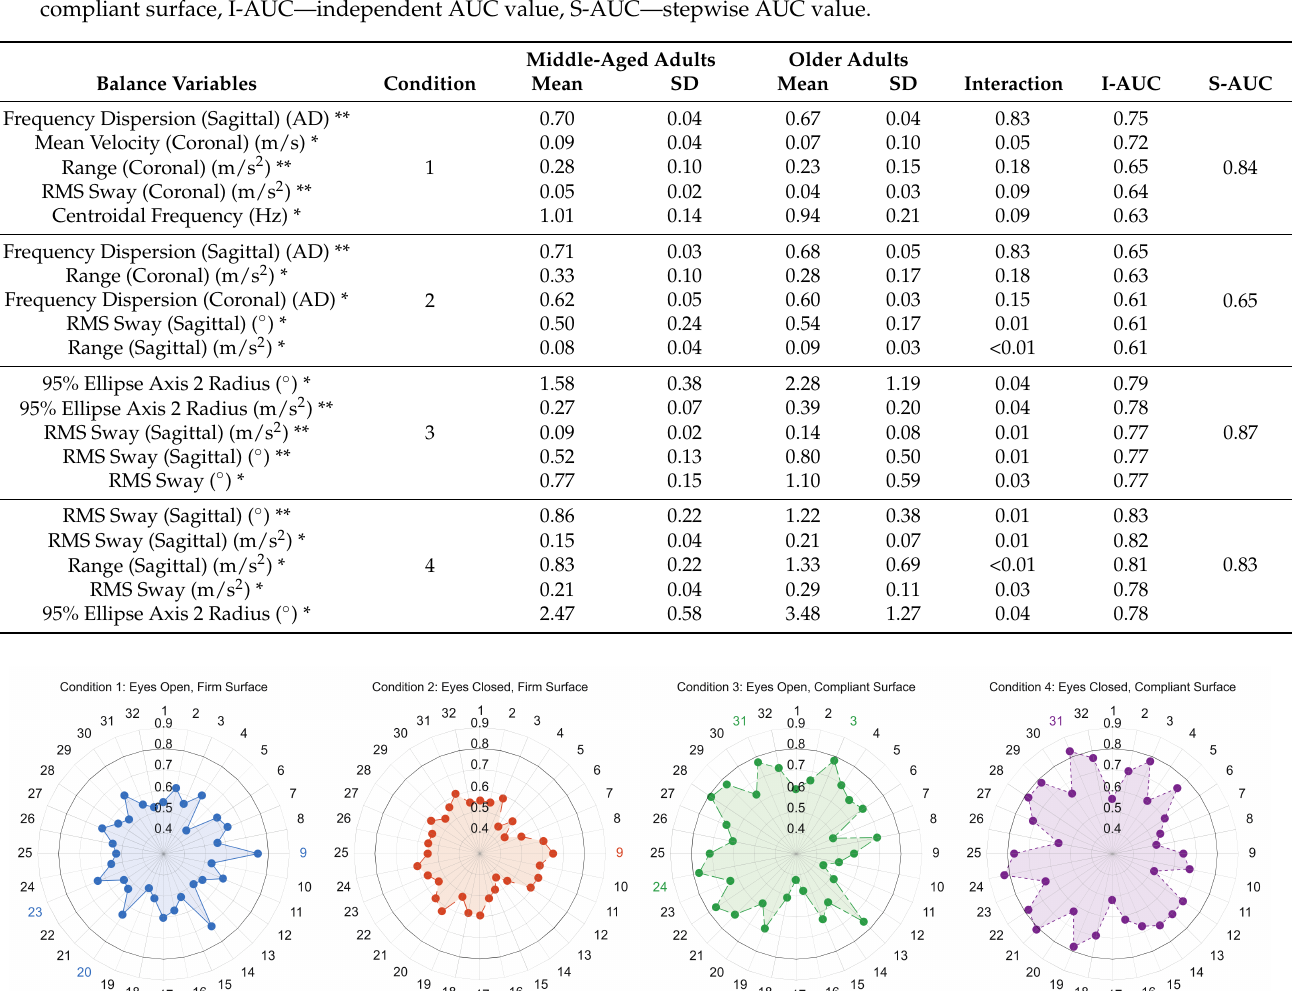
Table 9. Top five AUC variables for each balance condition. The variable(s) with a solitary (*) denote a top five AUC variable for that condition, those with a double (**) were withheld in the stepwise regression model. Condition 1—eyes open, firm surface, Condition 2—eyes closed, firm surface, Condition 3—eyes open, compliant surface, Condition 4—eyes closed,